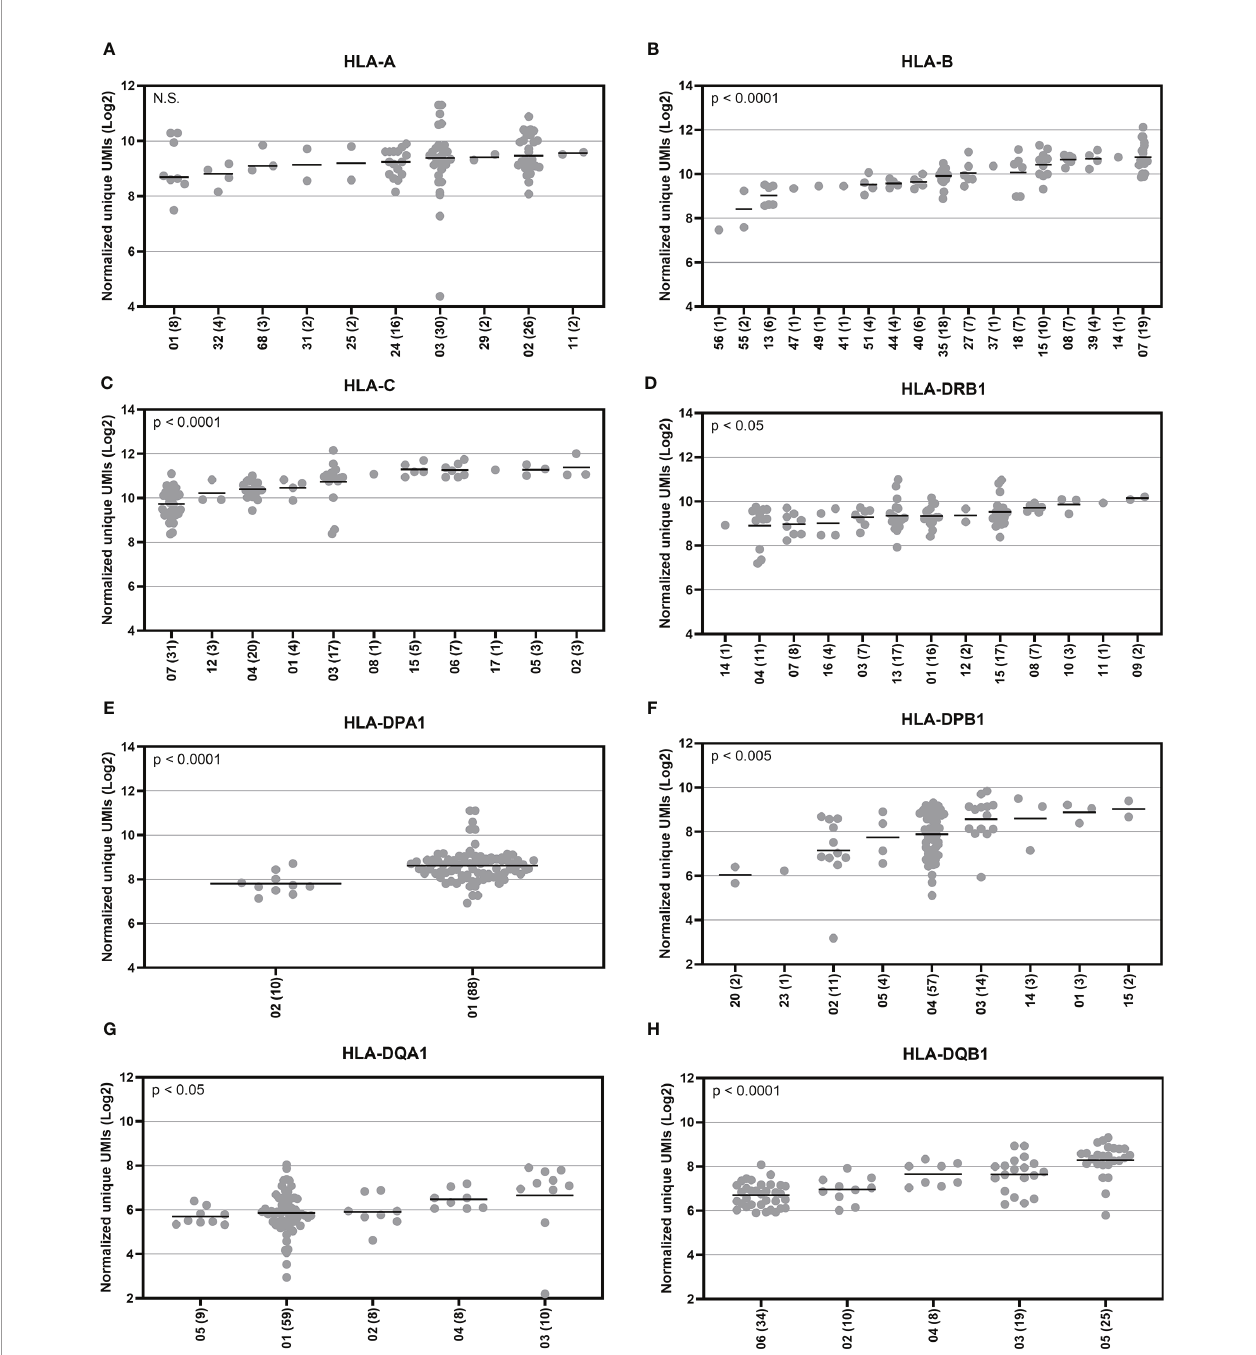
FIGURE 4 | Allotype expression of HLA class I and class II genes of 50 individuals. Allele-level UMIs of eight HLA genes (A – H) were normalized, grouped to allelic lineages, and plotted according to different lineages in Illumina cDNA data. Y-axis indicates the normalized unique UMIs (Log2) and X-axis indicates the names of the allelic lineages. Each dot refers to a UMI value and a solid bar indicates the median expression of the lineage. The number of samples are shown within parentheses. A Kruskal-Wallis test compared the ranks between the allelic